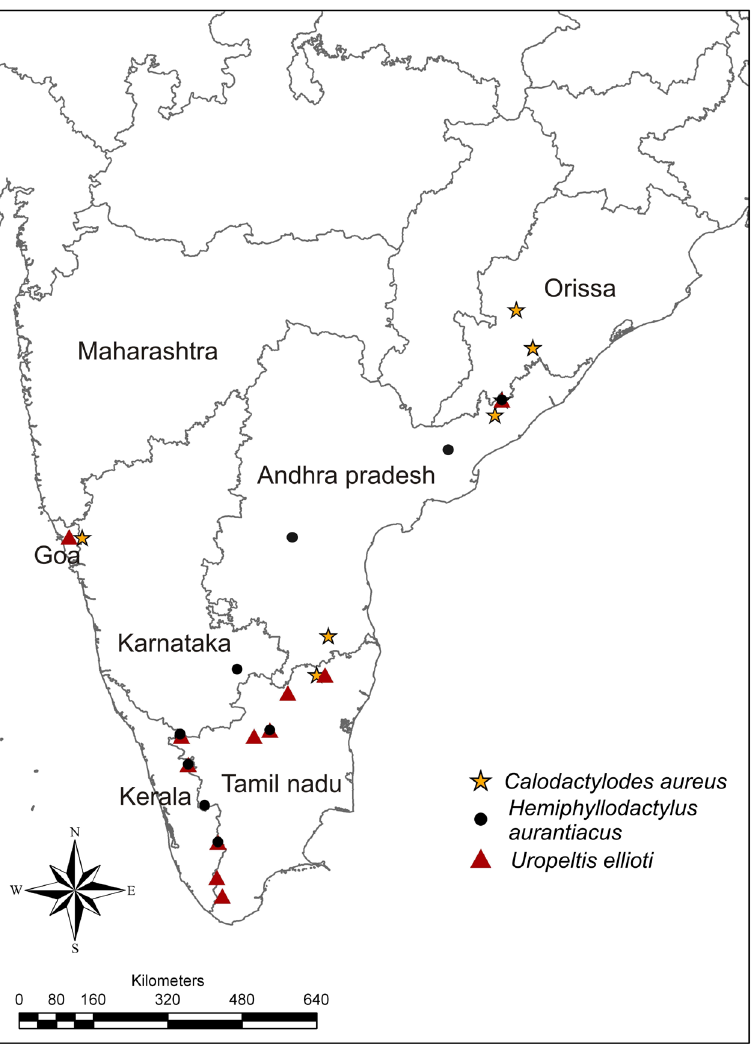
Figure 2. Map showing distribution records for Hemiphyllodactylus aurantiacus, Calodactylodes aureus and Uropeltis